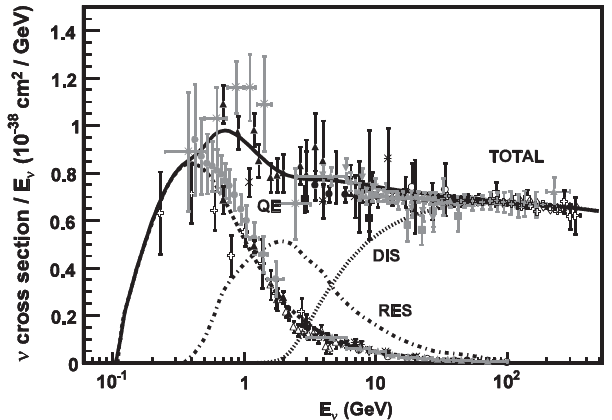
FIG. 1. Neutrino charge current cross sections as a function of neutrino energy [19 – 20]. RES: resonance-mediated, DIS: deep inelastic scattering, QE: quasielastic, and TOTAL: total cross